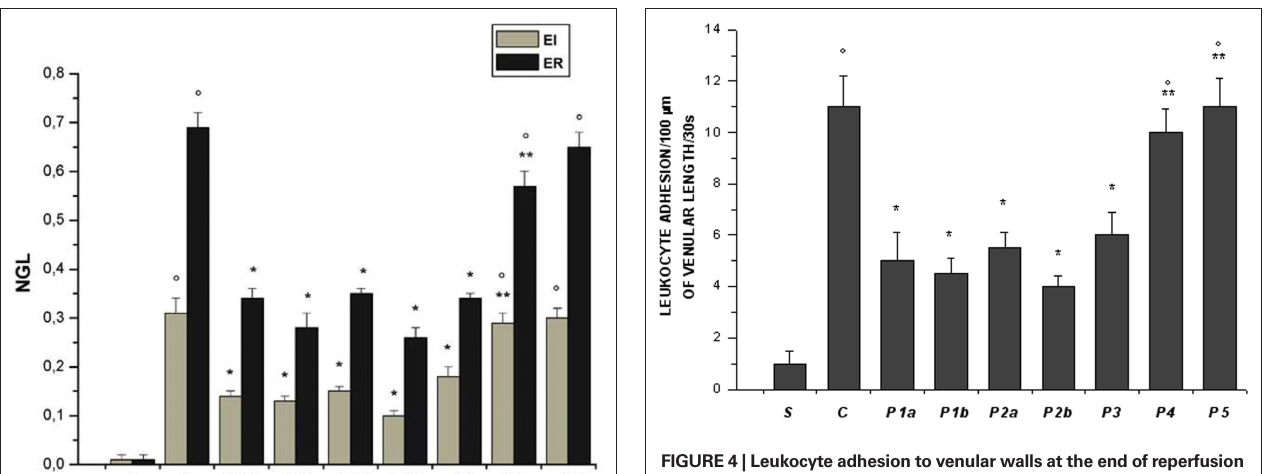
FiGuRE 4 | Leukocyte adhesion to venular walls at the end of reperfusion in the experimental groups, as reported in Figure 2 legend. ° p < 0.01 vs.